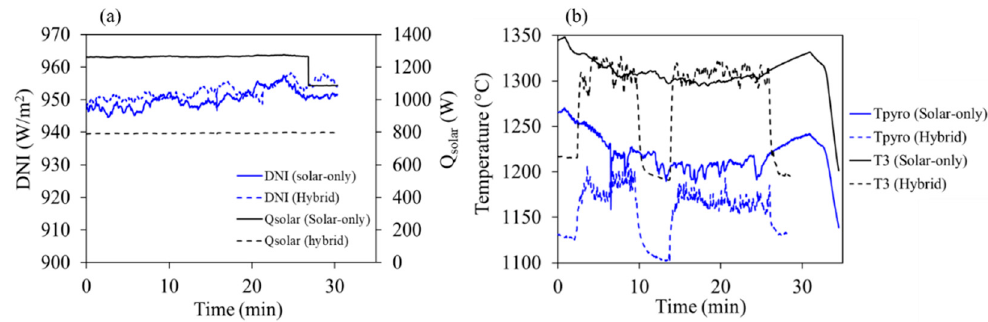
Figure 4. ( a ) Solar power input and DNI; ( b ) reactor temperatures for the two heating modes.